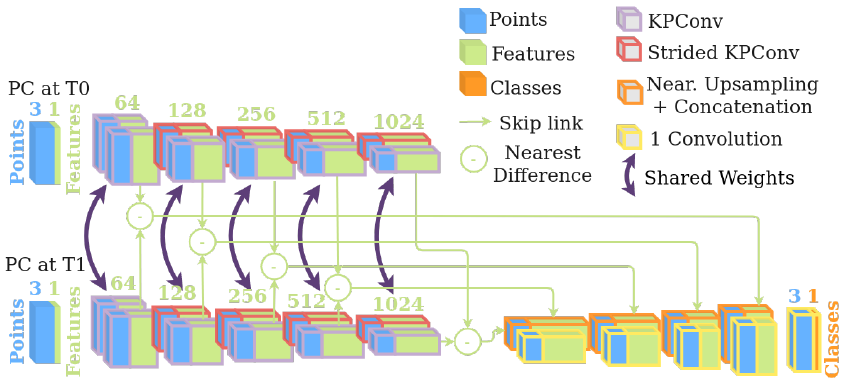
Figure 3. Siamese KPConv network architecture (de G´elis et al., 2021).